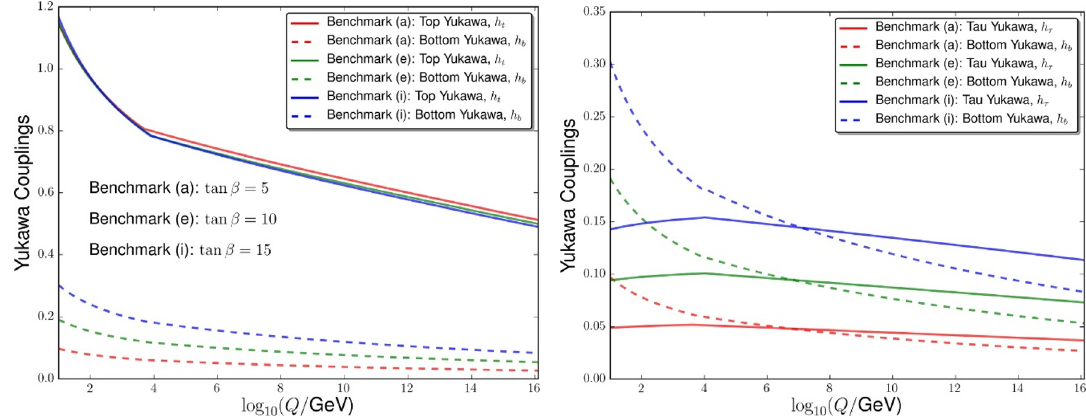
Figure 2 . Left panel: the running of the top and bottom Yukawa couplings for benchmarks (a), (e) and (i). Right panel: the running of the bottom and tau Yukawas for the same benchmarks.